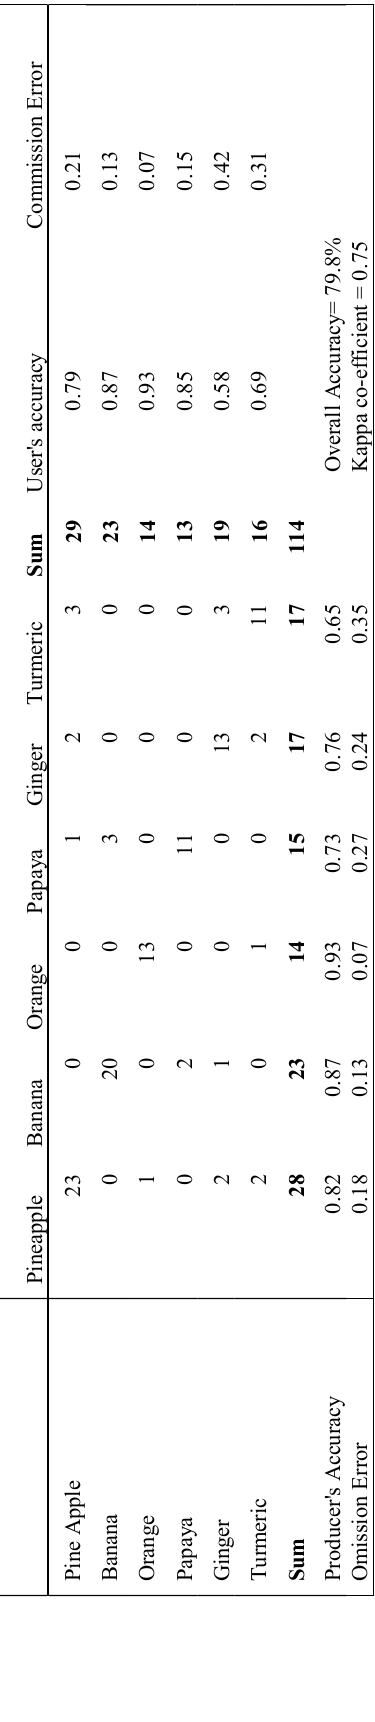
Table 5. Confusion matrix for Level-2 classification (horticultural